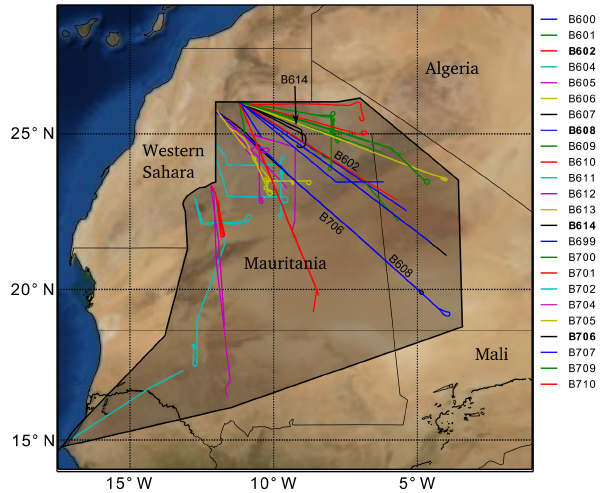
Figure 1. Domain of interest in the Sahara desert, with flight tracks of the BAe146 during Fennec. The shaded polygon surrounds the sampling area. Important flights, which are analysed in detail throughout the text, are